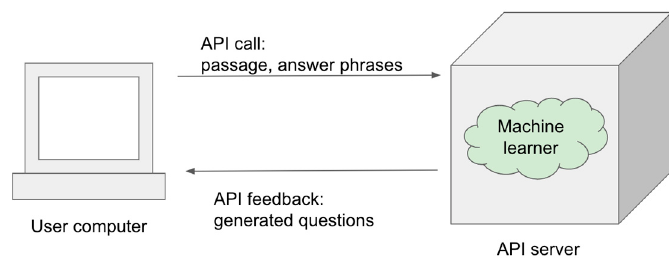
Figure 6. API communication between the user side and the API server.